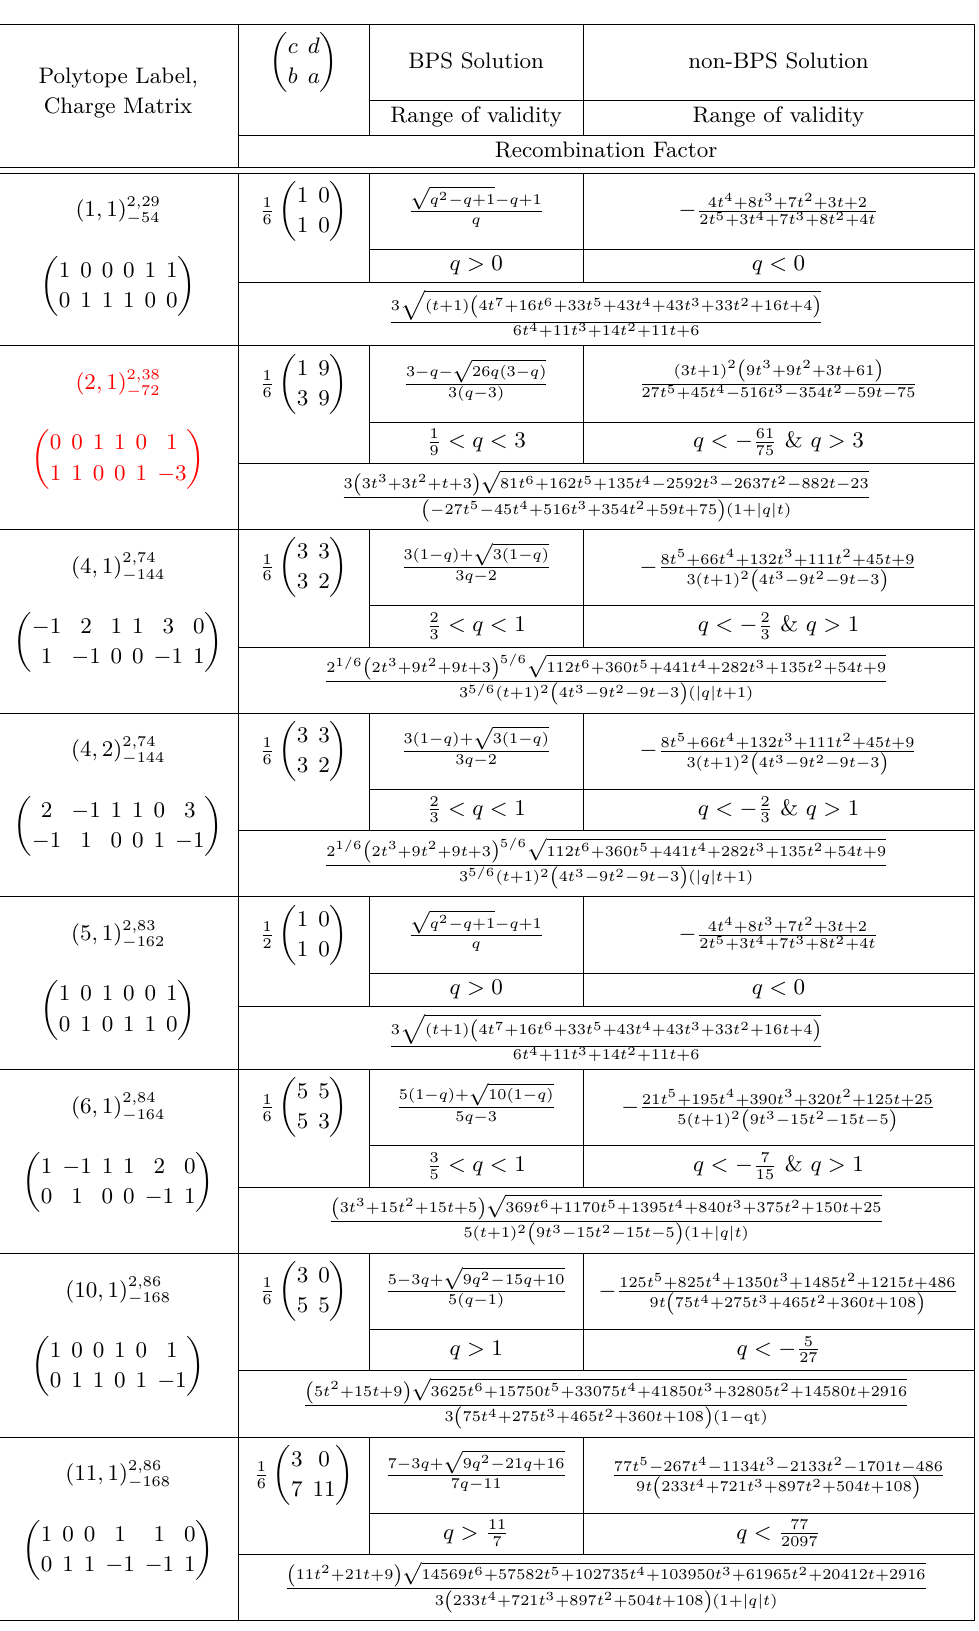
Table 4 . BPS and non-BPS extremal black holes in one-modulus THCY models,